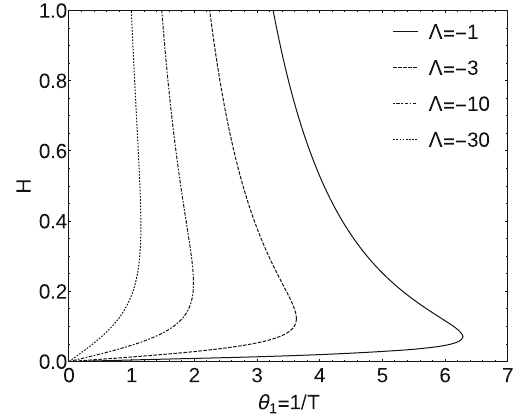
Fig. 6 Plot of θ 2 as a function of P at fixed θ